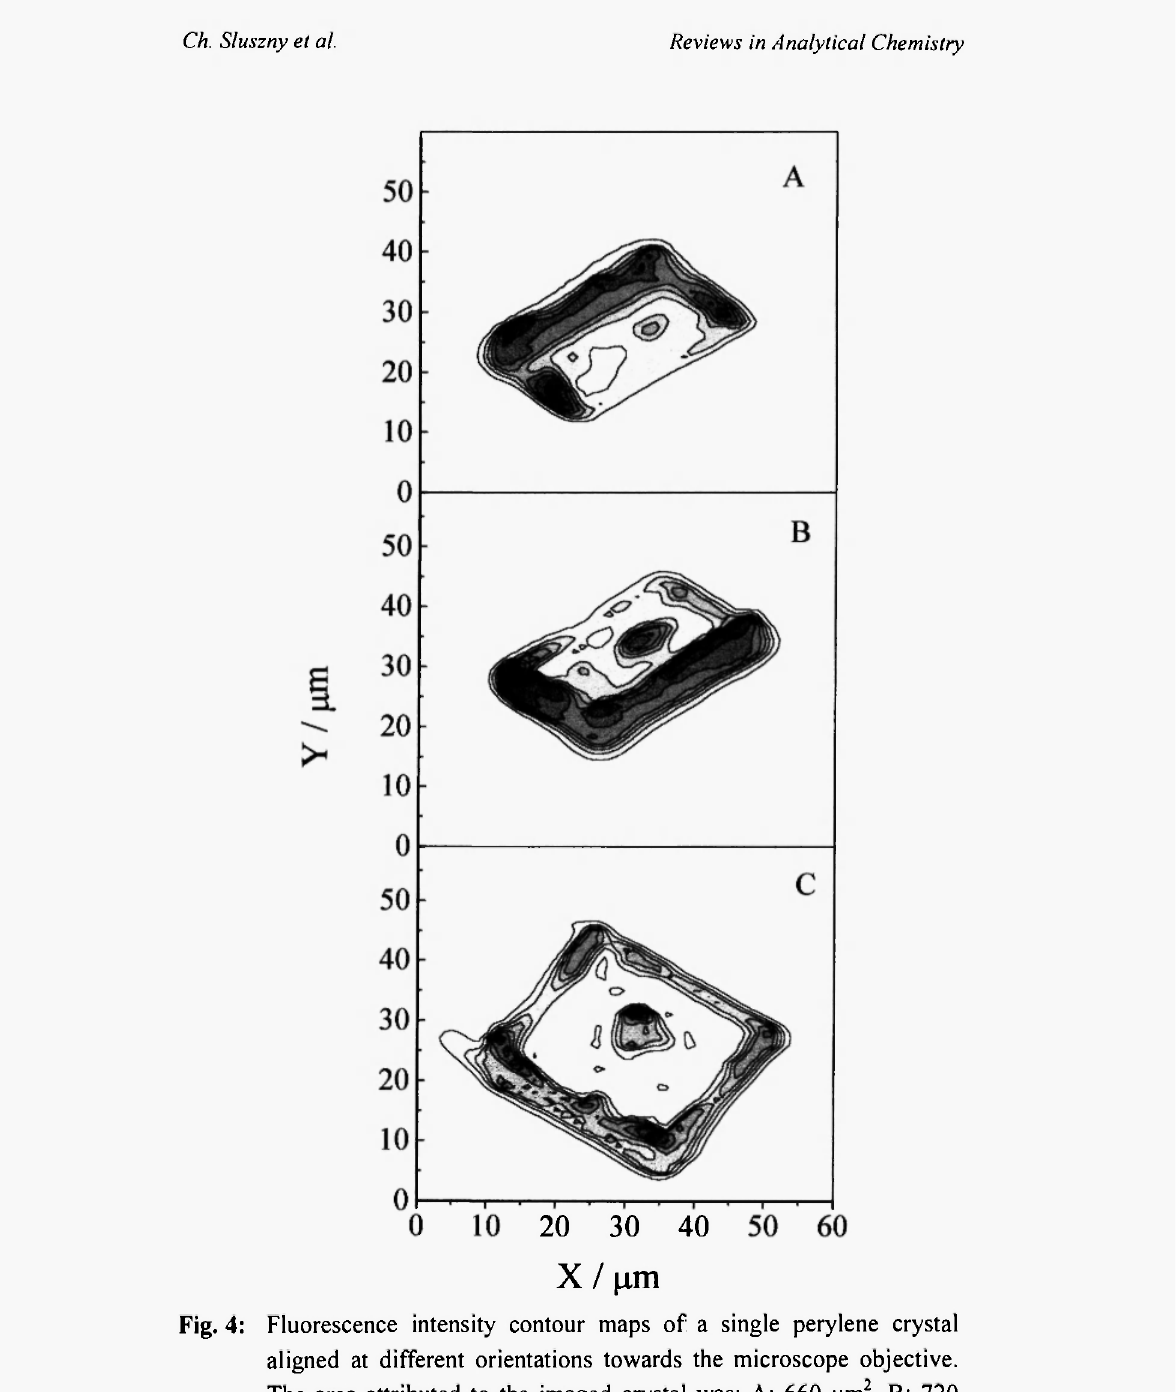
Fig. 4: Fluorescence intensity contour maps of a single perylene crystal aligned at different orientations towards the microscope objective. The area attributed to the imaged crystal was: A: 660 μηι 2 , Β: 720 μιη 2 , C: 1130 μηι 2